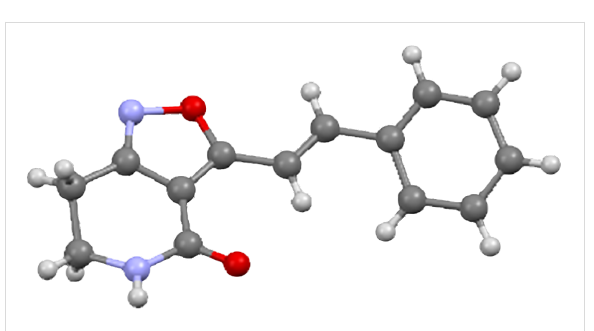
Figure 2: X-ray crystal structure of 3-(2-phenylethenyl)-4,5,6,7-tetrahy- droisoxazolo[4,3- c ]pyridin-4-one ( 8a ) [19].